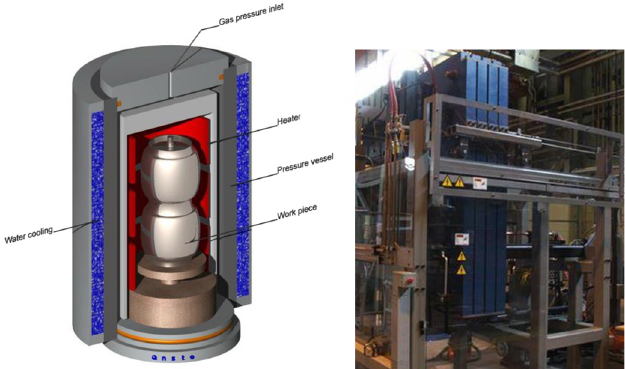
Fig. 8. Schematic of HIP (left: courtesy of ANSTO) and HIP installed at NNL Workington